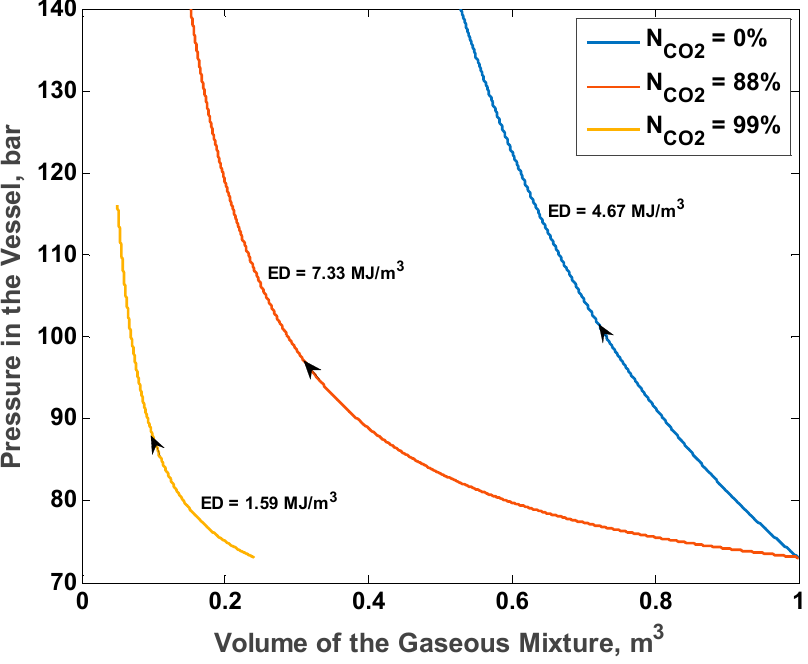
Figure 8. P–V diagram for P i = 73 bar and three di ff erent initial total CO 2 mole fractions: minimum, optimal, and maximum.